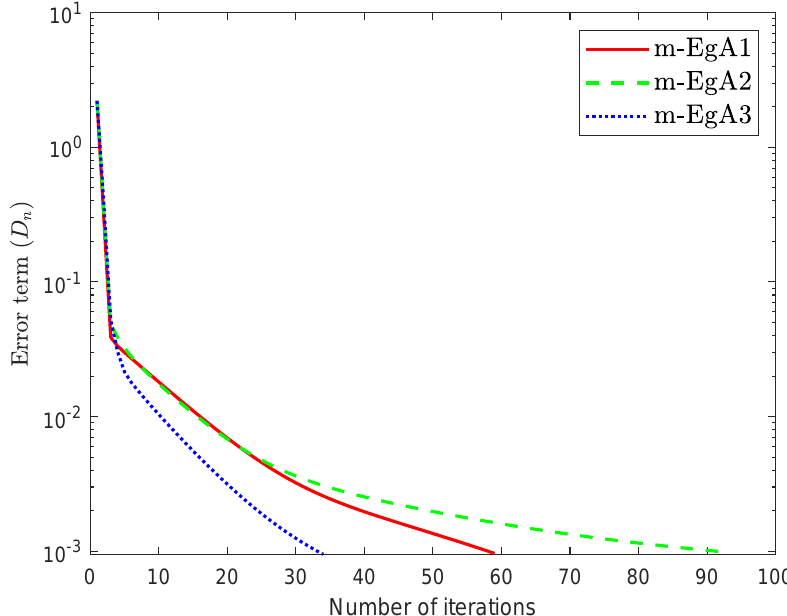
Figure 1. Numerical behaviour of Algorithm 1 compared to Algorithm 1 in [30] and Algorithm 2 in [30] for Example 1, when m = 5.